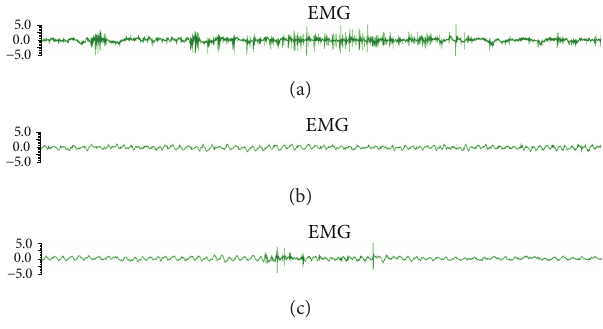
Figure 2: EMG recording during wake and REM sleep in 10-second epochs in an HP rat. (a) Muscle activity during wake. (b) Atonia during REM sleep. (c) Muscle activity during REM